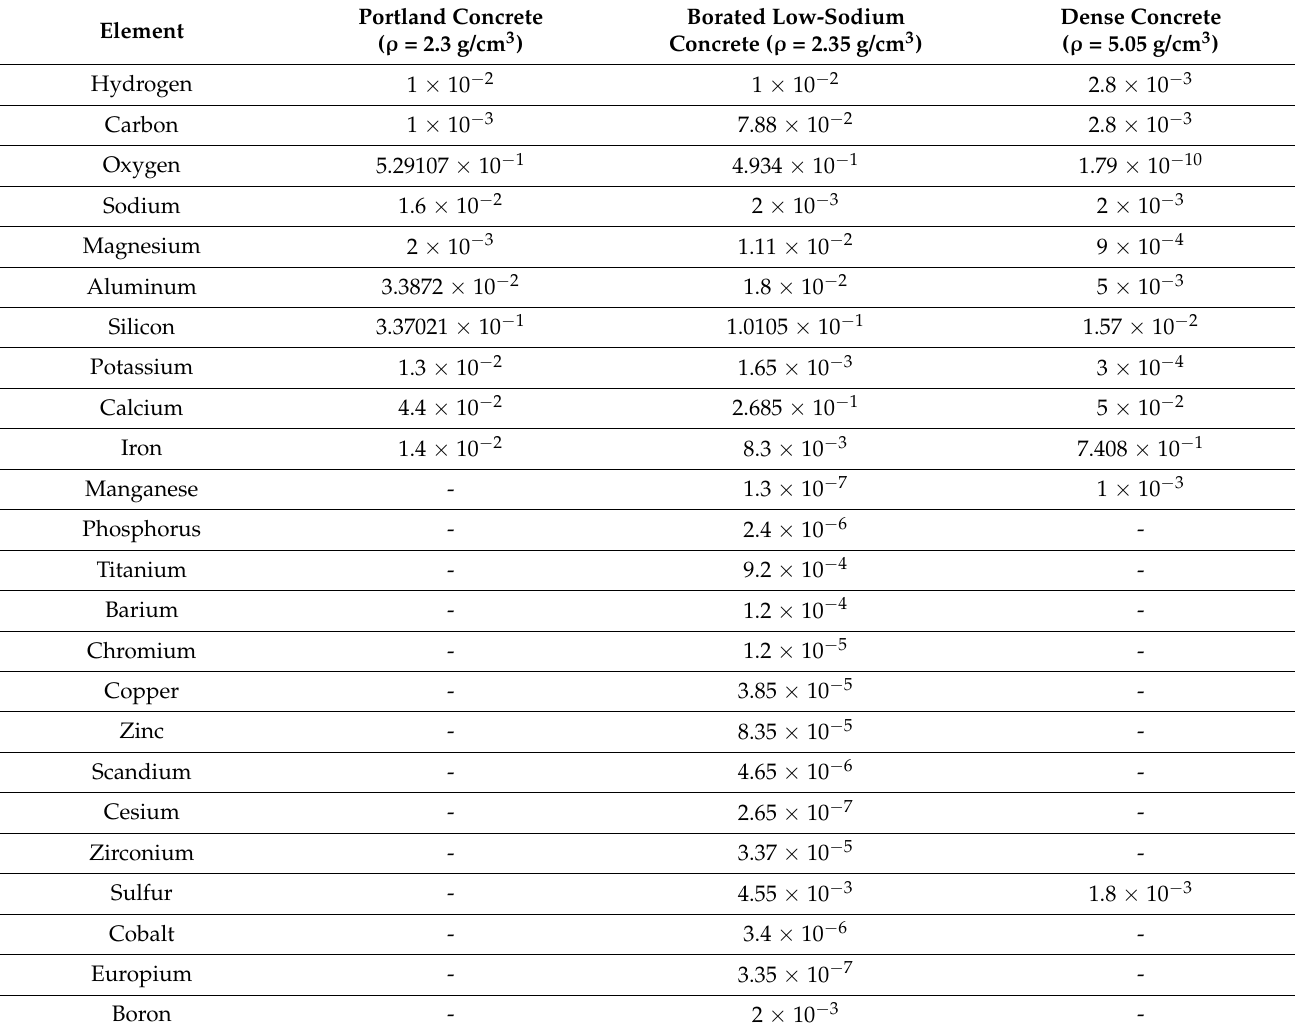
Table A1. Mass fraction of different shielding materials in the